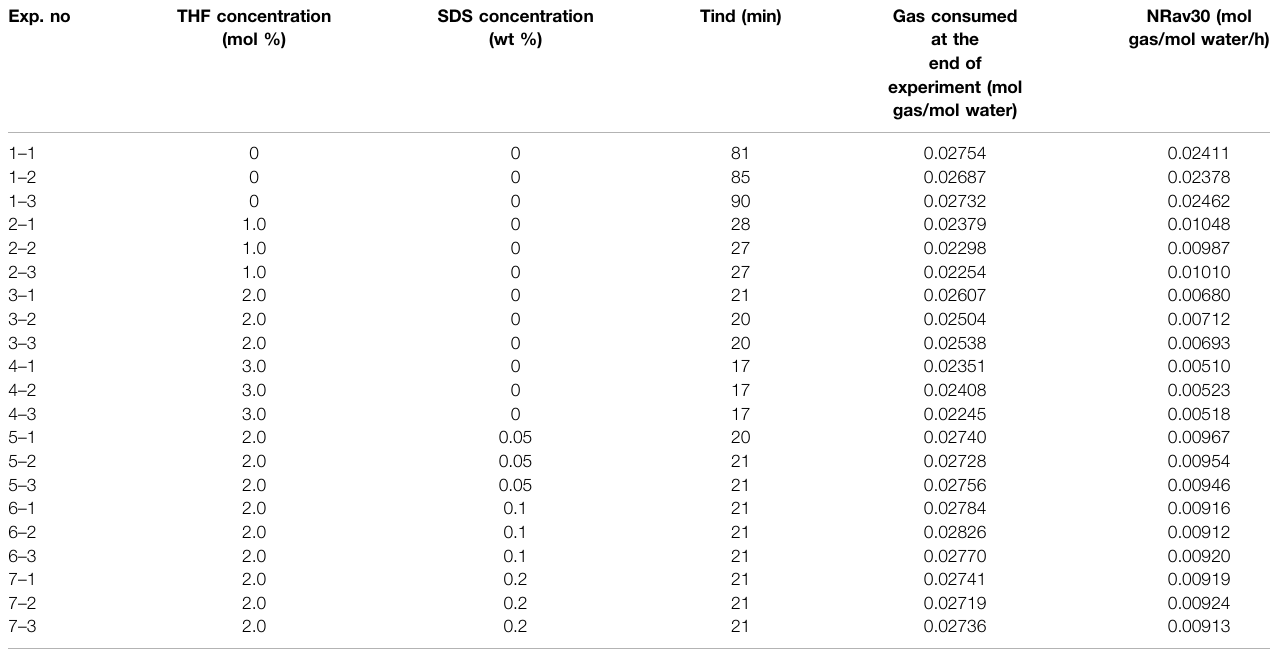
TABLE 1 | Summary of experimental conditions and results for CO 2 hydrate formation at 3.0 MPa. Exp. no